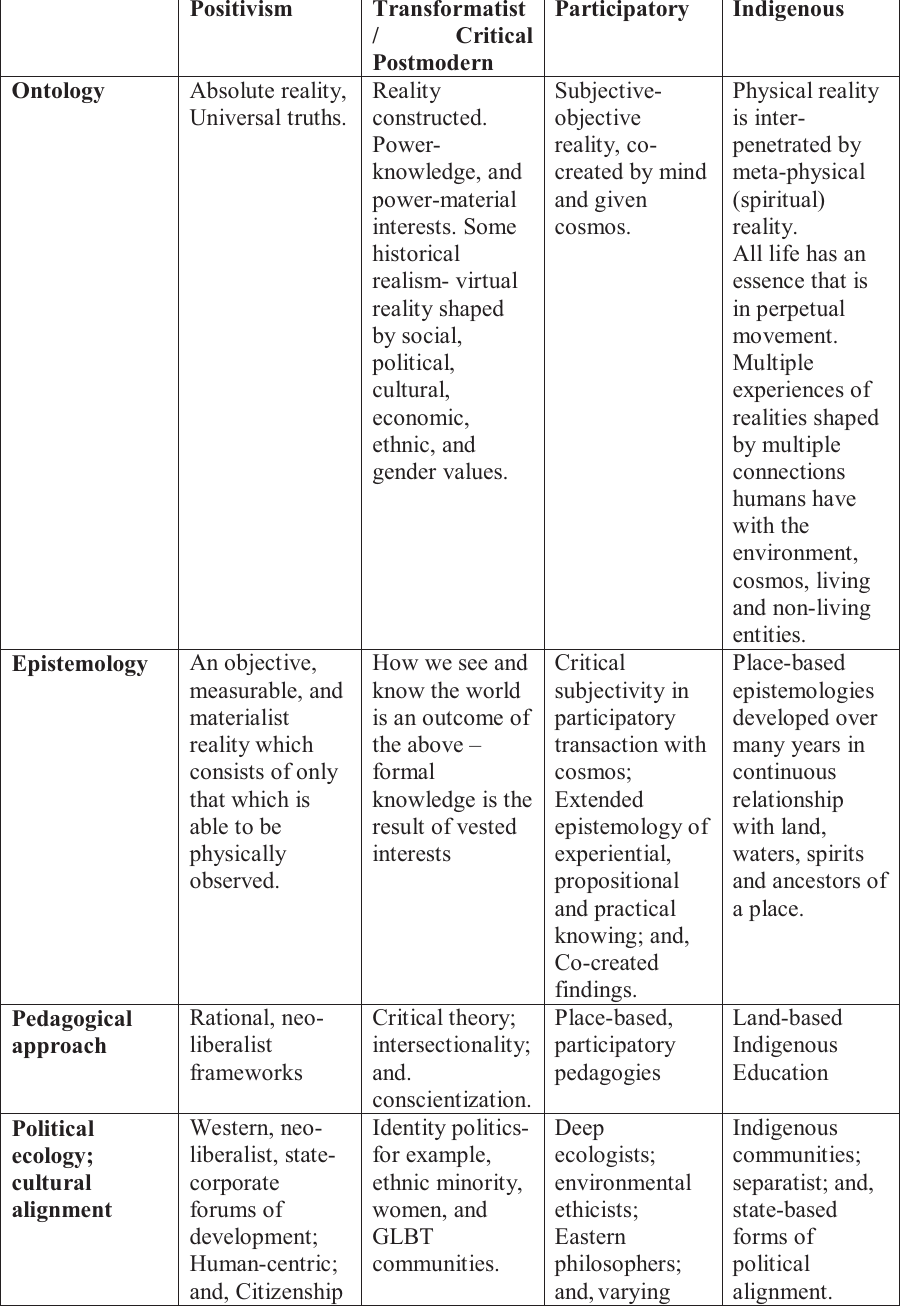
Pedagogically, these affective methodologies provided a vital complement to the discursive elements of cultural remapping which told of Indigenous realities, many of these also viscerally grounded in our immediate learning